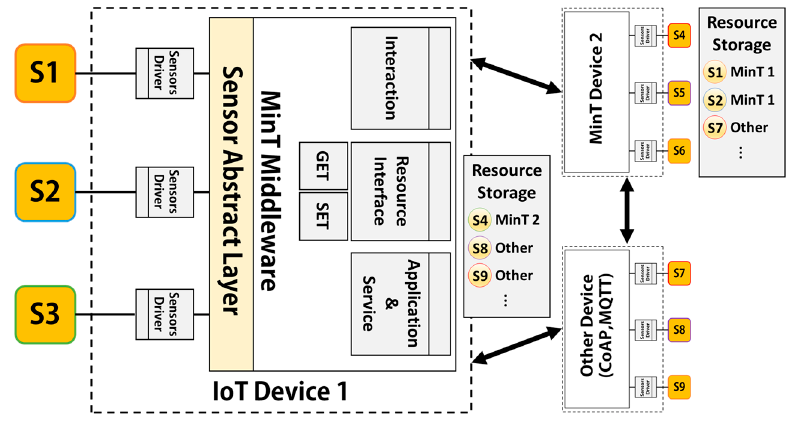
Figure 10. Interactions between IoT devices (MinT and other IoT deivce).